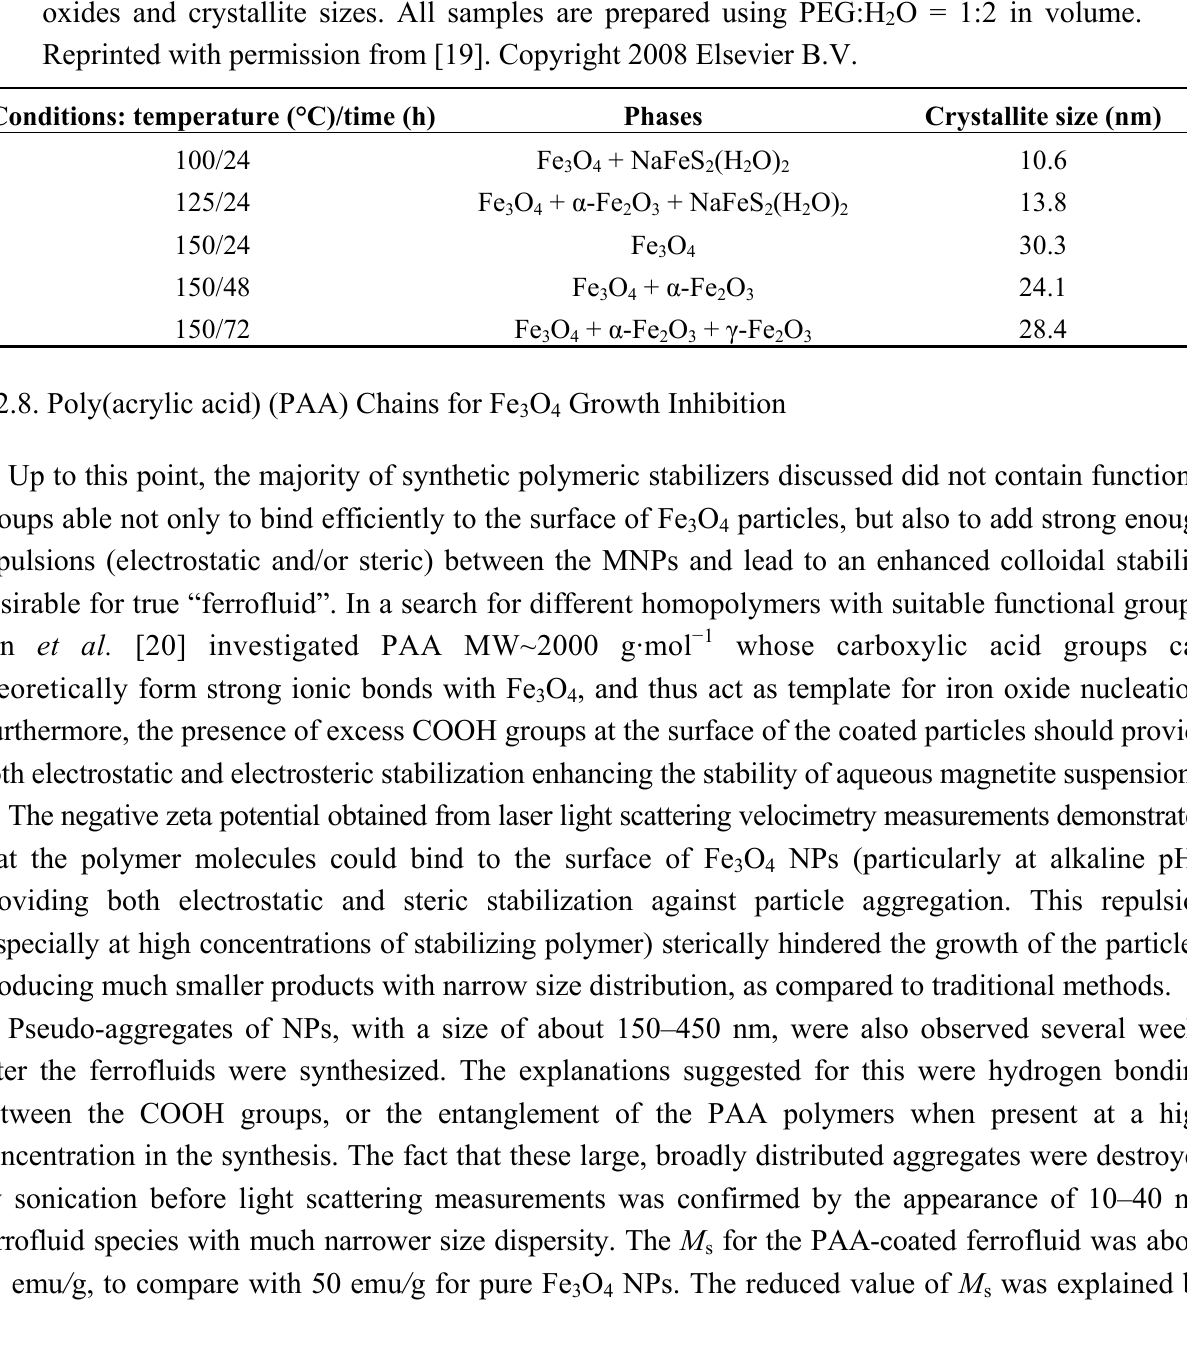
O = 1:2 in volume. 2